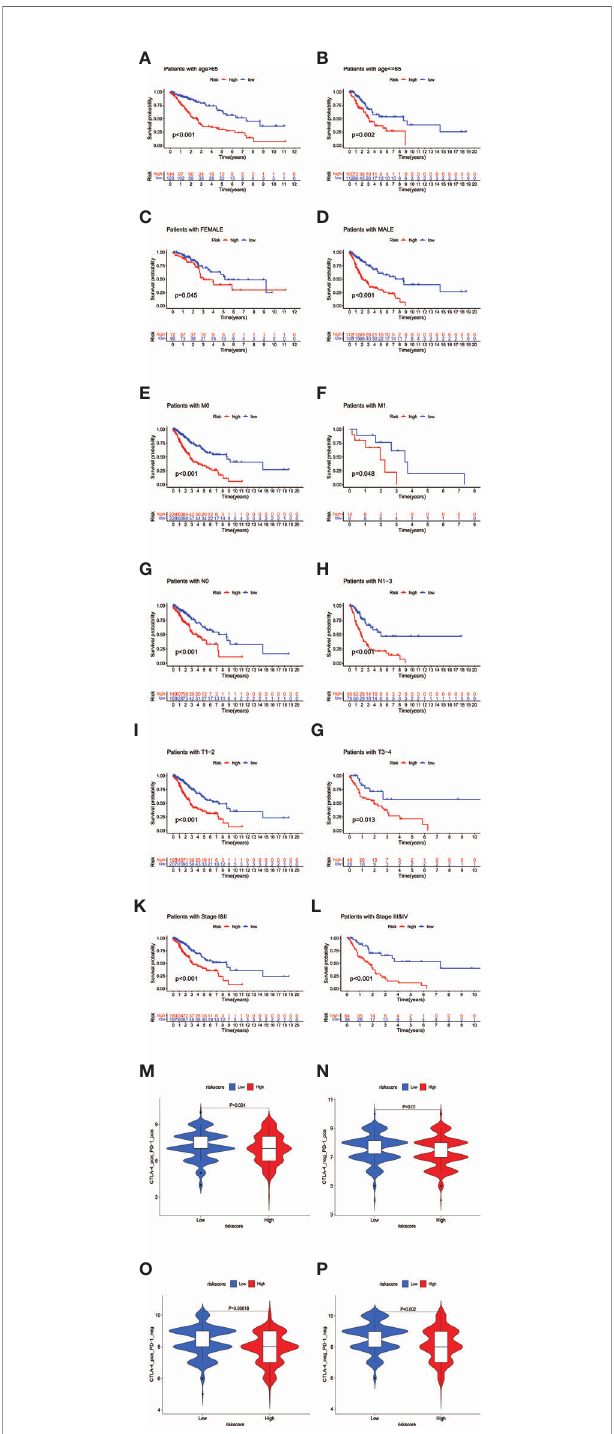
FIGURE 3 | (A – L) The prognostic signature well divided the high- and low- risk patients for survival in diverse clinical parameters (age, gender, M stage, N stage, T stage, and pathological stage). (M – P) The low-risk patients showed higher immunophenoscores in all four subgroups, CTLA-4 positive PD-1 positive, CTLA-4 negative PD-1 positive, CTLA-4 positive PD-1 negative, and CTLA-4 negative PD-1 negative, suggesting a better response to immunotherapies regardless of the expression of CTLA-4 and